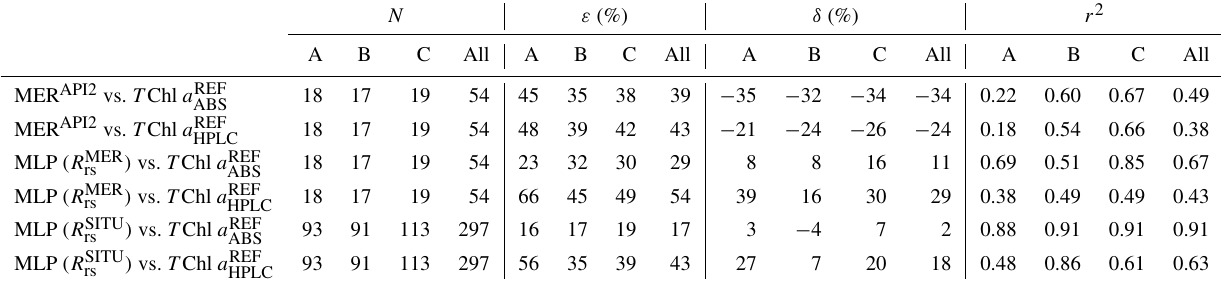
Table 1. Comparison of the standard (MER API2 ) , the regional bio-optical algorithms MLP( R MER rs ) and MLP( R SITU rs ), and the TChl a REF .